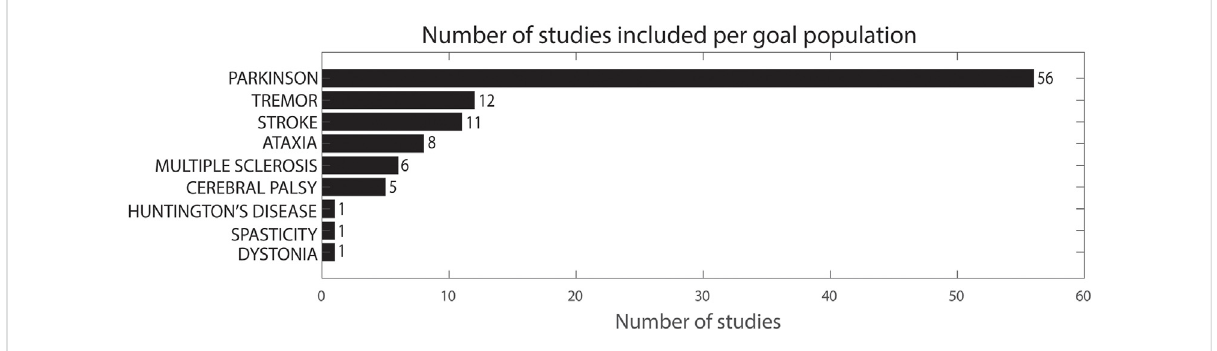
FIGURE 2 Number of studies included per goal population.